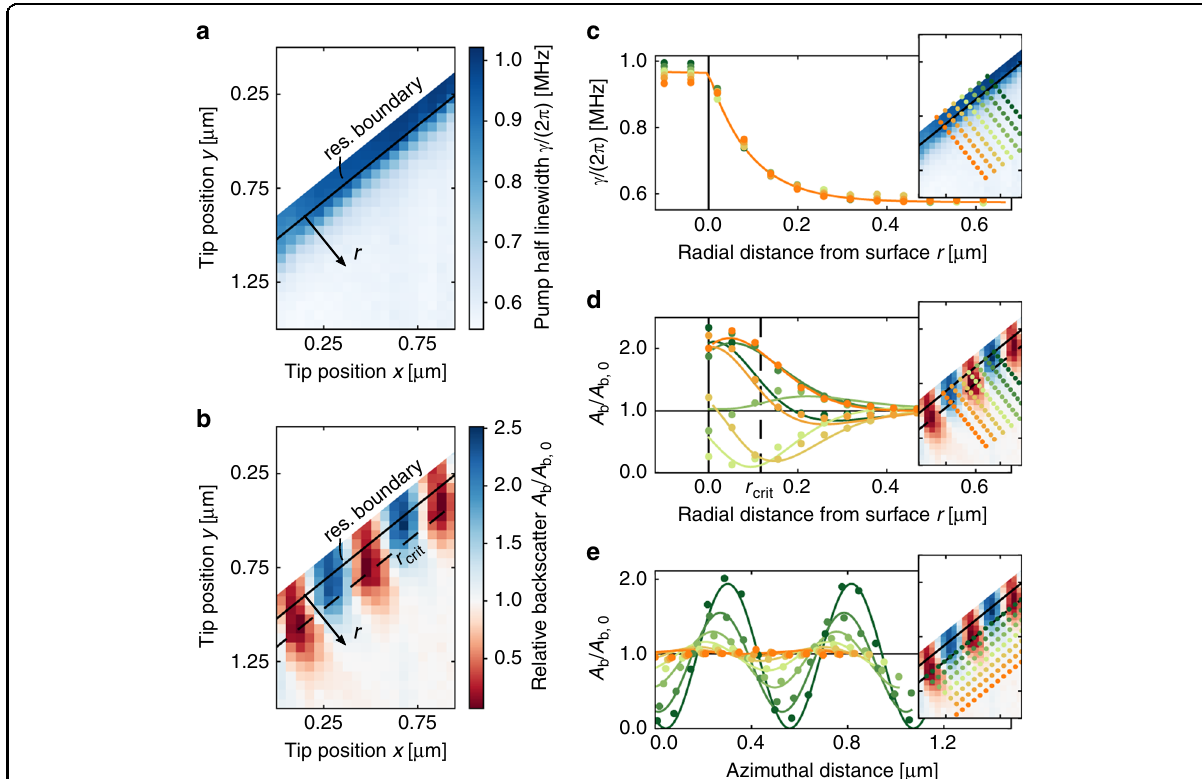
Fig. 3 Resonator response to the tungsten tip in the near fi eld. a Total linewidth (and equivalently Q-factor) and b backscattering amplitude for tip positions in the resonator plane, normalised by the intrinsic backscattering amplitude A b,0 . The black lines ( r = 0) indicate the fi tted resonator surface – measurements shown as r < 0 were obtained while the tip was touching the resonator surface, resulting in the tip sliding along the surface. Maximum backscattering suppression is found along the dashed line ( critical tip coupling ); for r < r crit , the tip is over-coupled , reducing the suppression. c – e Fits (lines) and interpolated data (circles) along cross sections through the experimental data in panels a and b. The insets show where the cross sections were taken. c Radial tip position dependence of the linewidth and d backscattering. e Tip azimuthal position dependence of the